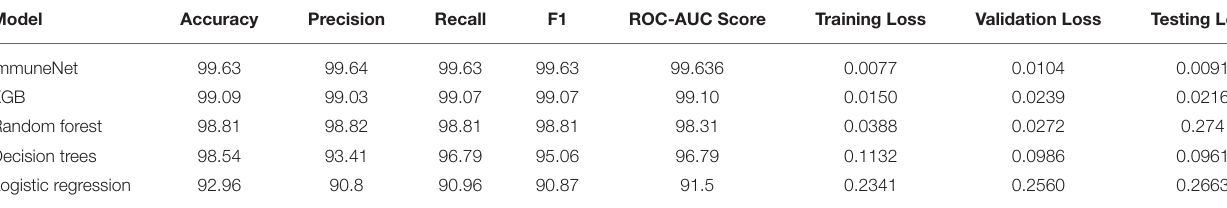
TABLE 8 | Comparison of models based on respective evaluation metrics for CIC IDS 2017. Model